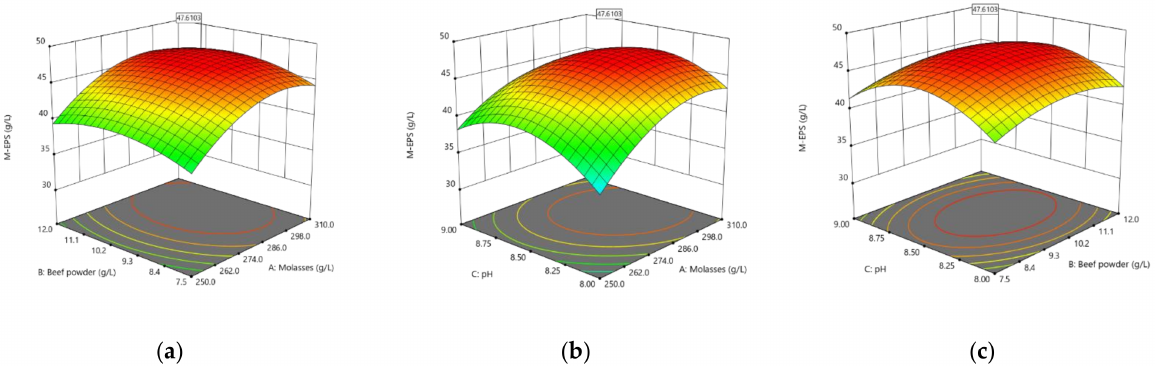
Figure 6. The 3D response surface showing the interactive effect of independent variables on M-EPS yield. ( a ) Molasses and Beef powder; ( b ) Molasses and Initial pH; ( c ) Beef powder and Initial